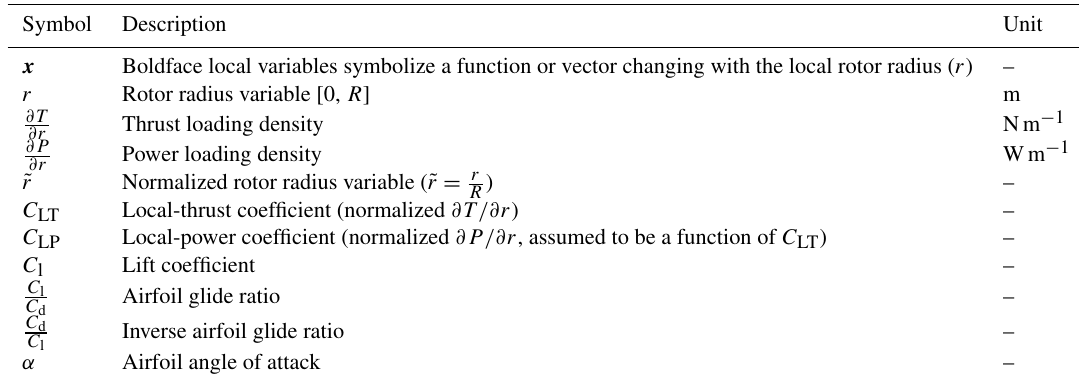
Table A2. Variables that are scalars at a given radius location ( r ). Boldface variables indicate it is a function or vector changing with